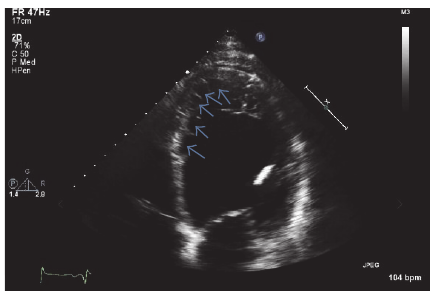
Figure 2: Two-dimensional echocardiogram in our patient demon- strating prominent trabeculations and deep intratrabecular recesses (marked by arrows).